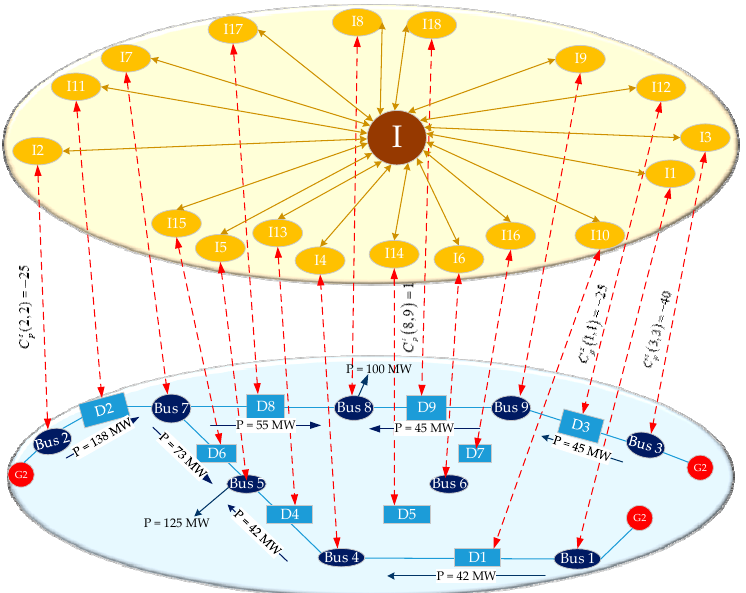
Figure 5. State machine of node fault state of CPPS.